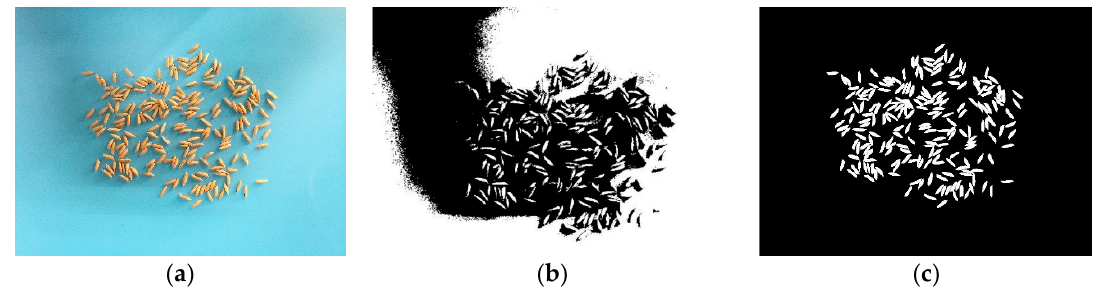
Figure 4. The extraction of Indica Rice binary images using the Otsu segmentation algorithm and K-means clustering segmentation algorithm; ( a ) Original image of Indica rice; ( b ) Binary image of Indica rice based on Otsu algorithm; ( c ) Binary image of Indica rice based on K-means clustering algorithm.